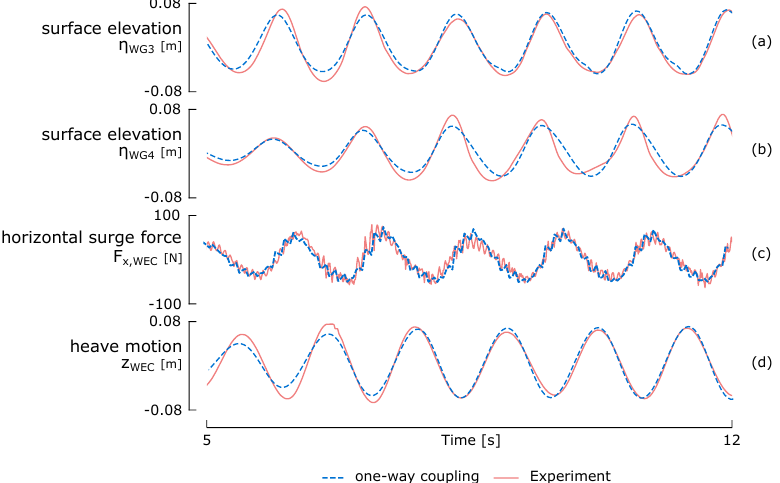
Figure 13. Comparison of a one-way coupling 3D proof-of-concept with experimental data of a heaving cylinder in overtopping nonlinear waves. ( a ) shows the surface elevation 1 m in front of the WEC; ( b ) the surface elevation 1 m behind the WEC; ( c ) the horizontal surge force acting on the WEC and ( d ) the heave motion of the